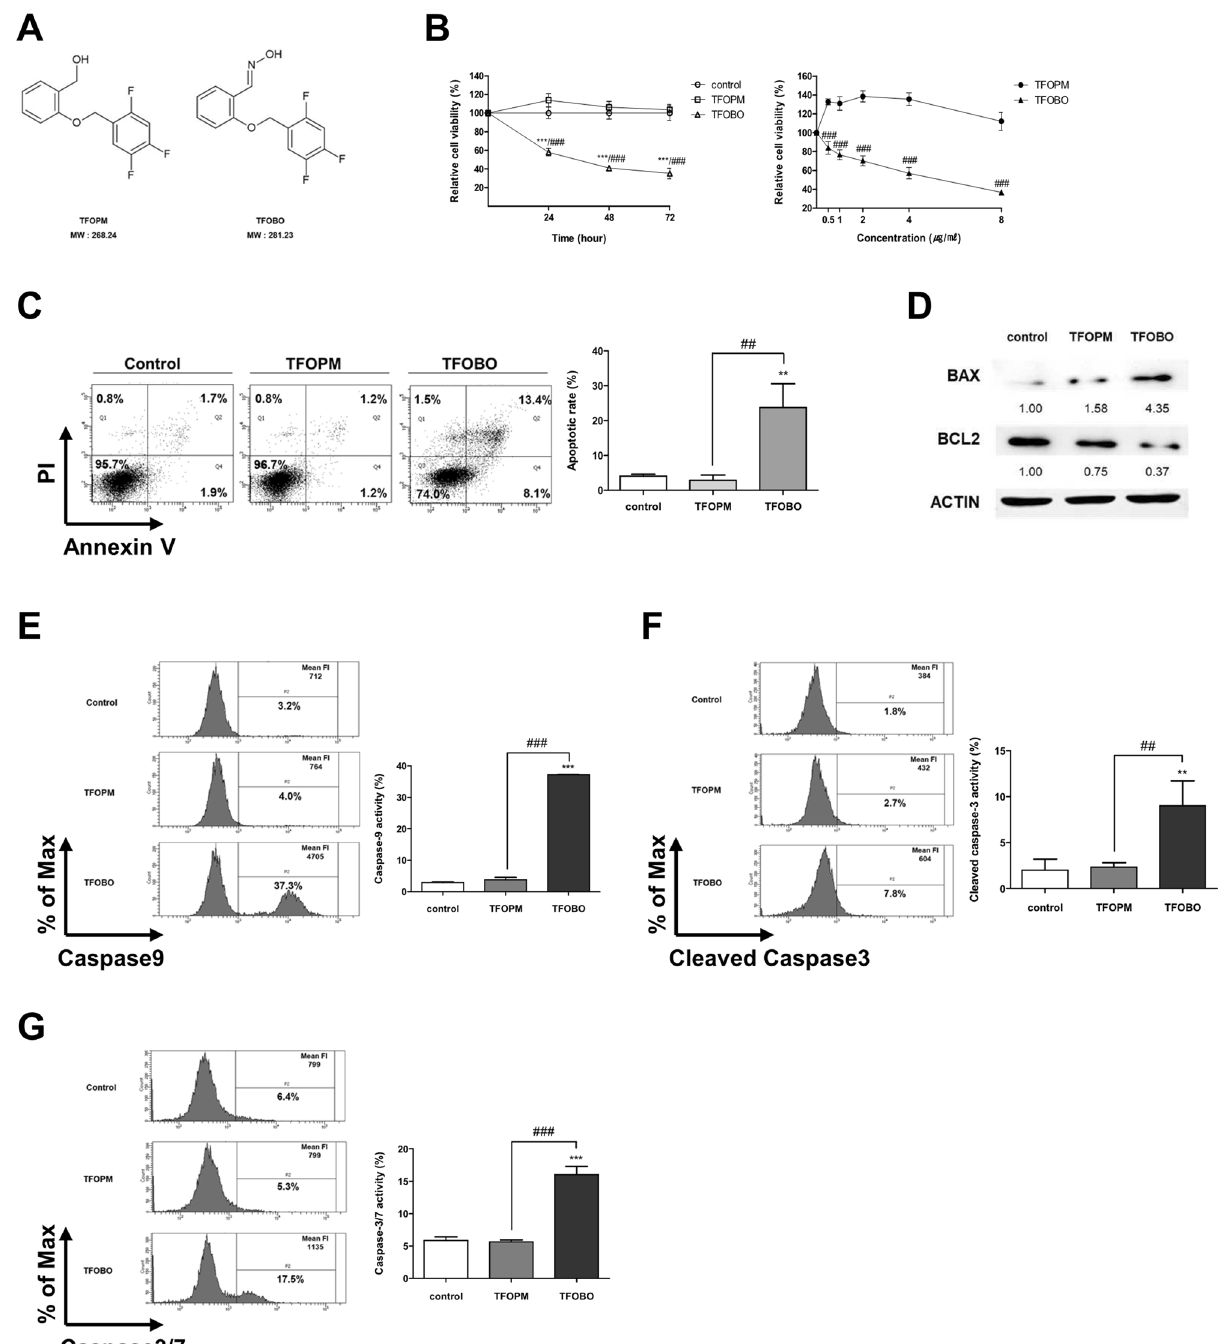
Figure 1. Exogenous addition of ((2,4,5-trifluorobenzyl)oxy)-benzene derivative (TFOBO) affects myeloid leukemic cell growth. ( A ) Chemical structure of TFOPM and TFOBO. ( B ) Serum-starved THP1 cells are treated with 4 µg/ml of TFOBO for 24, 48, and 72 h (left) and then treated with indicated concentrations of TFOBO for 48 h (right). Cell viability is measured using a CCK-8 assay. (***p < 0.001 vs. control; ### p < 0.001 vs. (2-((2,4,5-trifluorobenzyl)oxy)phenyl)methanol [TFOPM]). ( C ) THP1 cells are serum-starved overnight and treated with 4 µg/ml of TFOBO for 48 h. The cells are double-stained with annexin V-APC and propidium iodide and analyzed by flow cytometry. The apoptotic cell percentage data are shown in the graph. (**p < 0.01 vs. control; ## p < 0.01 vs. TFOPM). ( D ) After 48 h incubation with 4 µg/ml of TFOBO, the THP-1 cells are lysed. After quantifying the protein concentration of cell lysate by bicinchoninic acid assay, equal amounts of proteins (20 µg) are separated by sodium dodecyl sulphate–polyacrylamide gel electrophoresis and transferred to the nitrocellulose membrane. The membrane is probed with anti-BAX and anti-BCL-2 antibodies. β-ACTIN is used as a loading control. The representative data of the western blot analysis are shown. ( E–G ) After serum starvation overnight and treatment with 4 µg/ml of TFOBO for 48 h, the caspase activity of THP1 cells is measured by flow cytometry. ( E ) FITC- LEHD-FMK is added to the cells, which are then incubated at 37 °C for 1 h, and the caspase9 activity is observed. ( F ) The cells are stained with cleaved caspase3 antibody after fixation and permeabilization and their fluorescence is measured. ( G ) For the detection of caspase-3/7 activity, the cells are treated with TF2-DEVD-FMK for 3 h and analyzed. (**p < 0.01, ***p < 0.0001 vs. control; ## p < 0.01, ### p < 0.0001 vs. TFOPM). The data in the graphs are presented as mean ± SD (n = 3 replicates for each group). Representative data from three independent experiments are